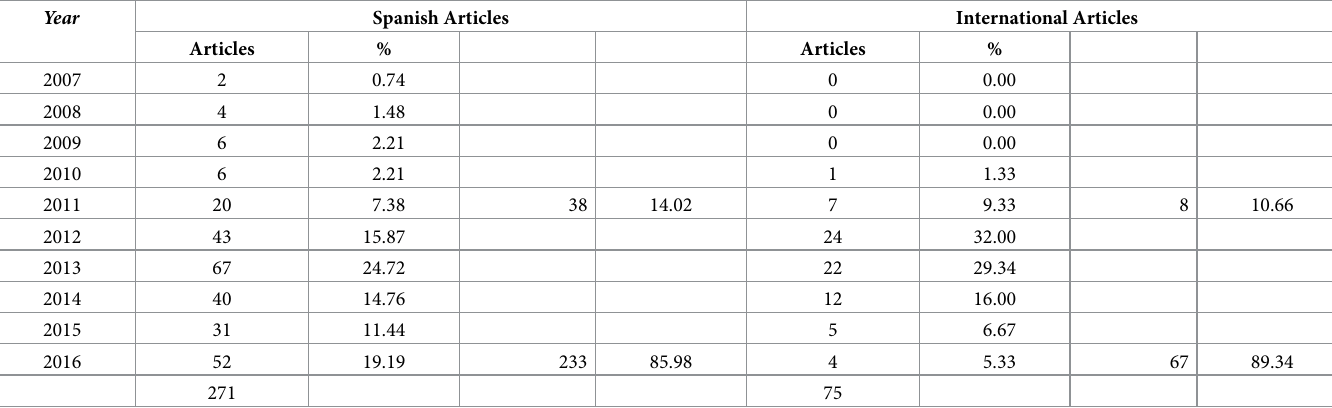
Table 4. Distribution of articles by year of publication and origin.